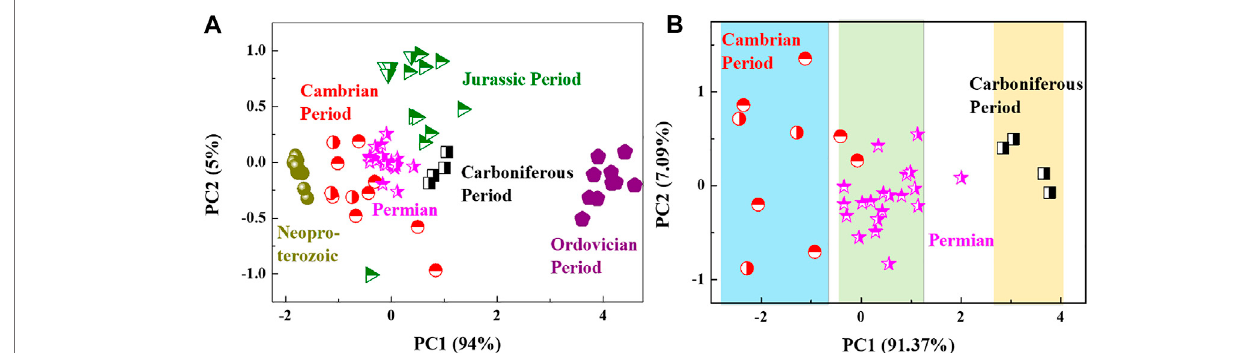
FIGURE 7 | (A,B) Vp/d principal component analysis.